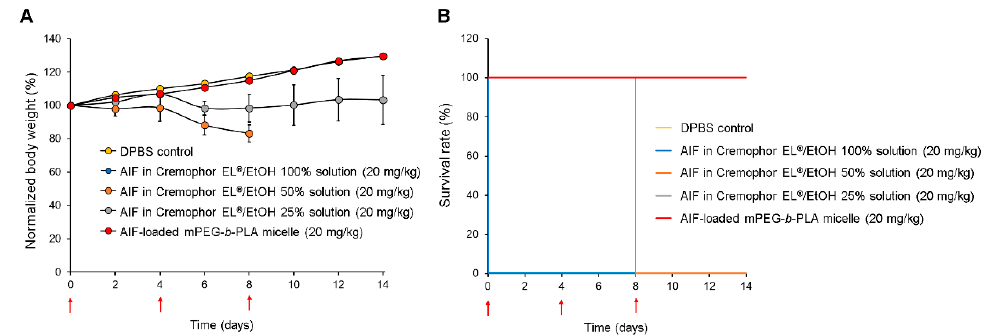
Figure 8. Relative body weight change and survival rate of rats after multiple intravenous (i.v.) injections of DPBS control, alpinumisoflavone (AIF) dissolved in 100% Cremophor EL ® /ethanol (EtOH) solution, AIF dissolved in 50% Cremophor EL ® /EtOH solution, AIF dissolved in 25% Cremophor EL ® /EtOH solution, and AIF-loaded mPEG- b -PLA micelles on day 0, 4, and 8. ( A ) Relative daily body weight change. ( B ) Survival rate demonstrated using Kaplan–Meier plot [42] . Red arrows indicate intravenous injections of the formulations.